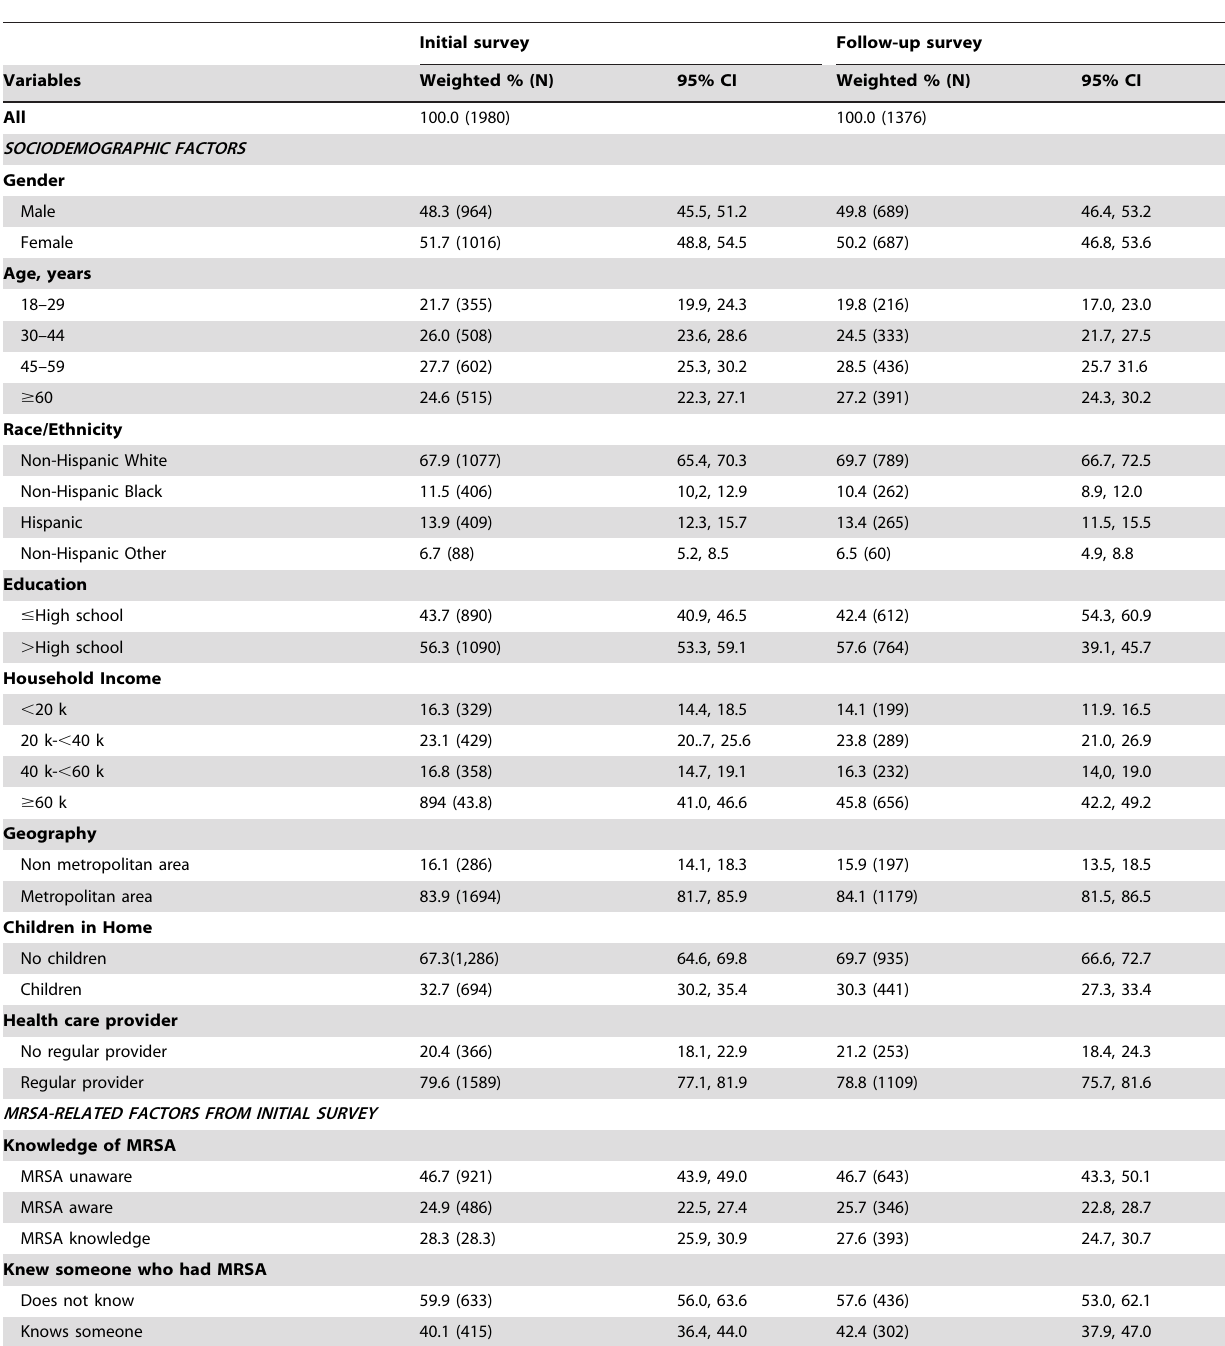
Table 1. Demographic Characteristics of Survey Respondents, Weighted to Reflect the National